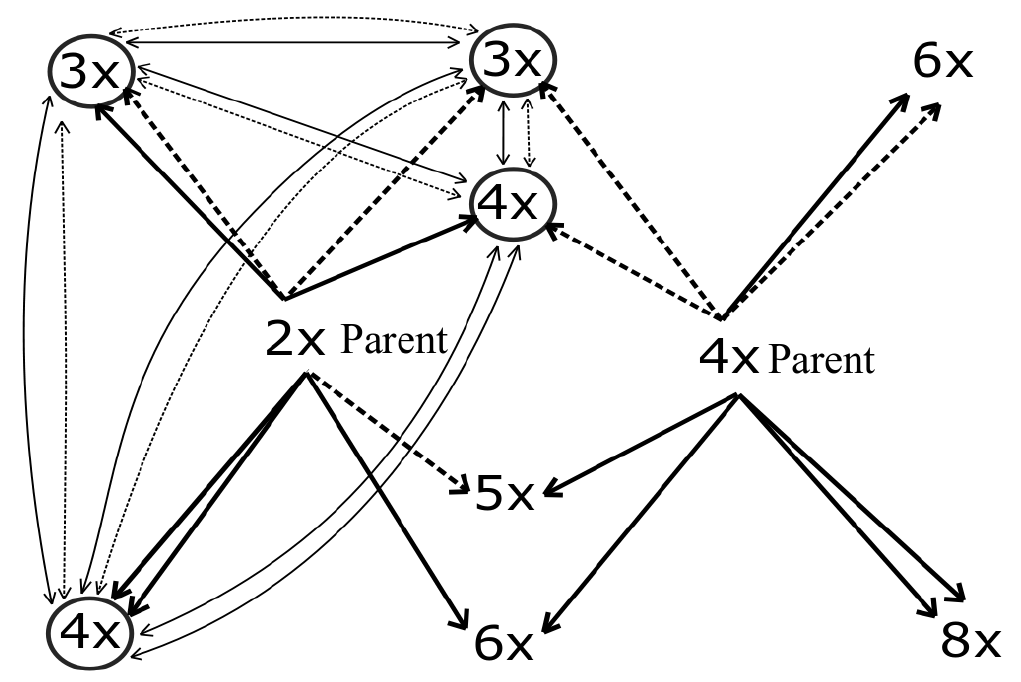
Figure 7. A theoretical overview of crosses involving reduced (dashed arrows) and unreduced (solid arrows) gametes of diploid and tetraploid parents (bold arrows) and possible crosses of the resulting offspring of the F1 generation (light arrows). The offspring that may arise in our case are circled.